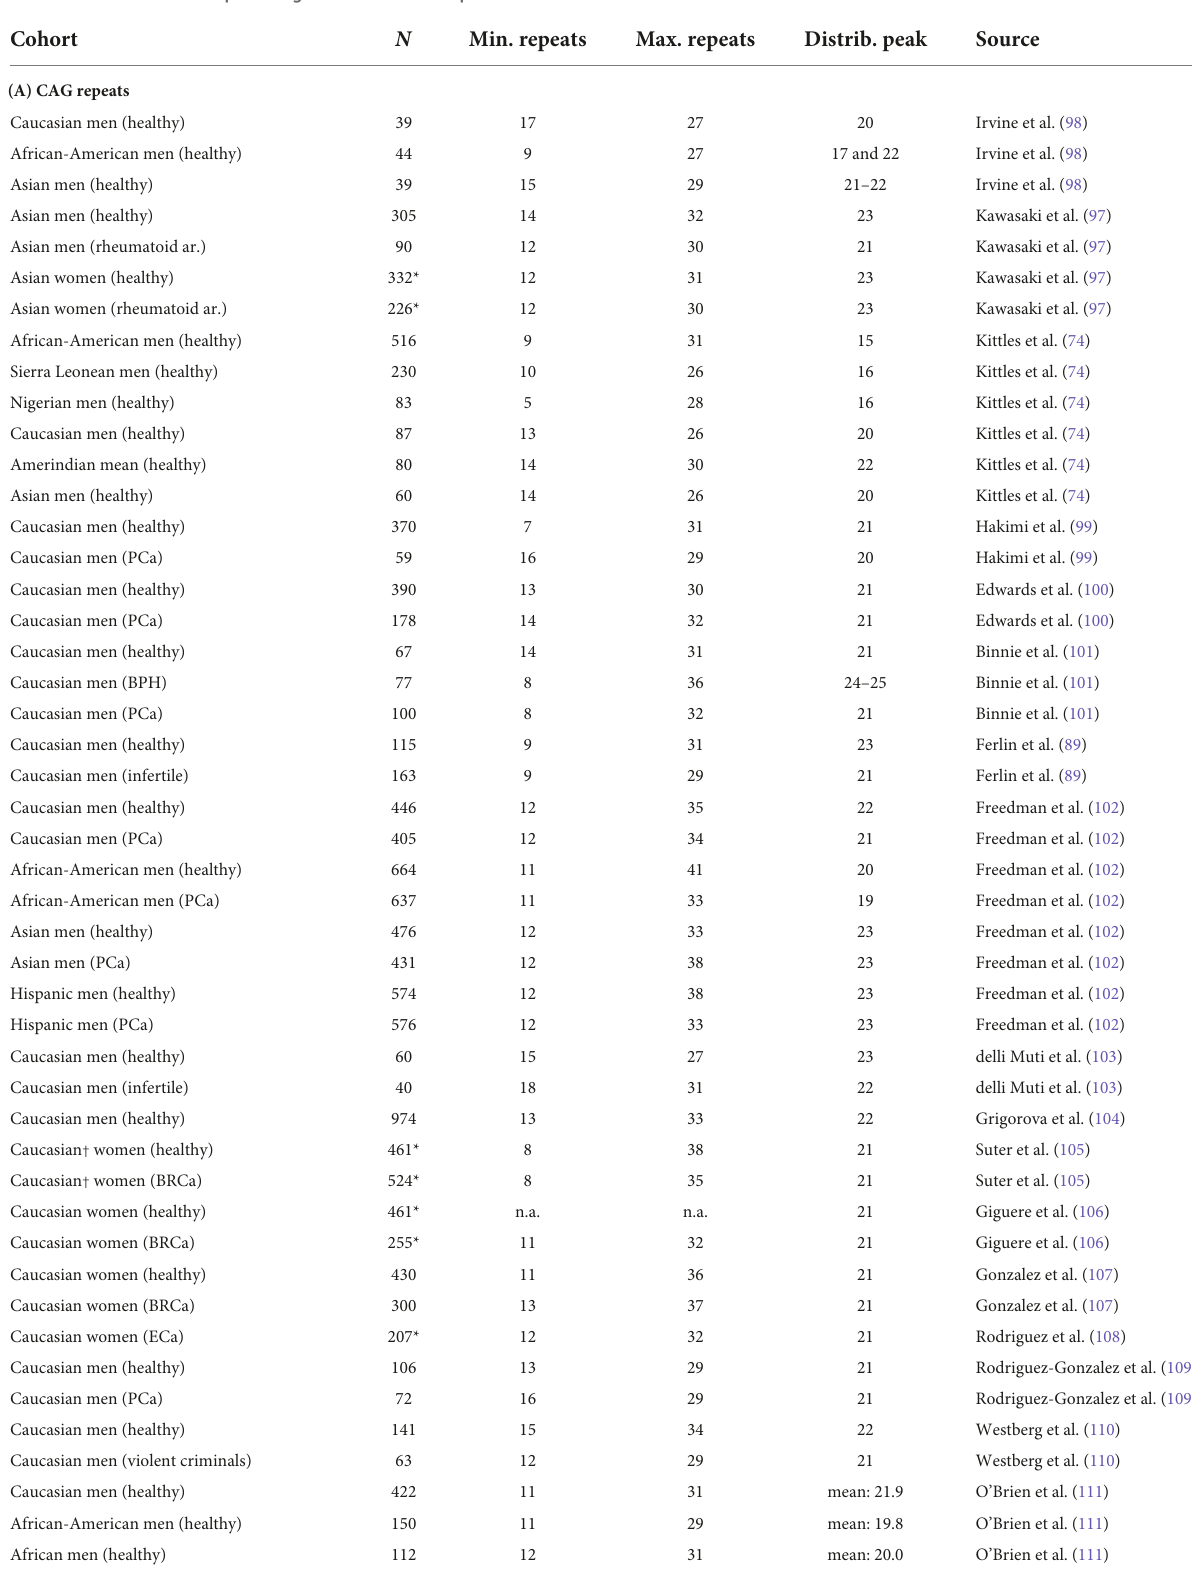
TABLE 1 CAG and GGN repeat ranges and distribution peaks across different cohorts. Cohort N Min. repeats Max. repeats Distrib. peak